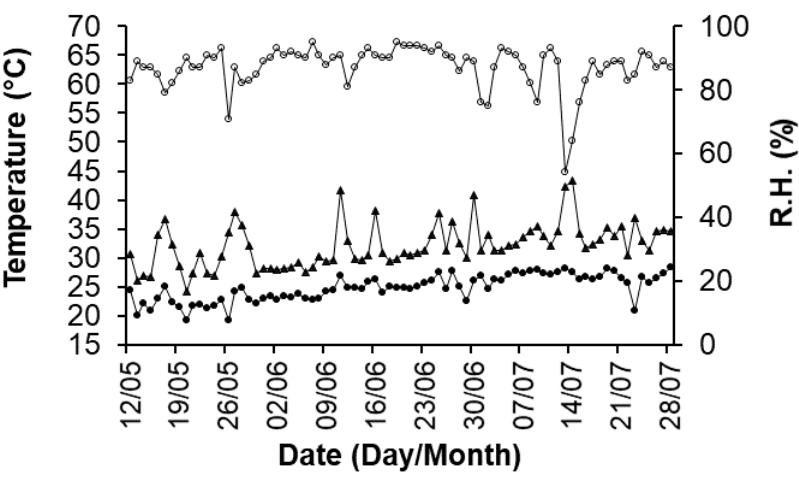
Figure 4. Relative humidity (R.H.; open symbols, right axis) and maximum and minimum air temperatures (solid symbols, left axis) during May–July 2017 inside a greenhouse in the experimental field at Battipaglia (Salerno, Campania region,